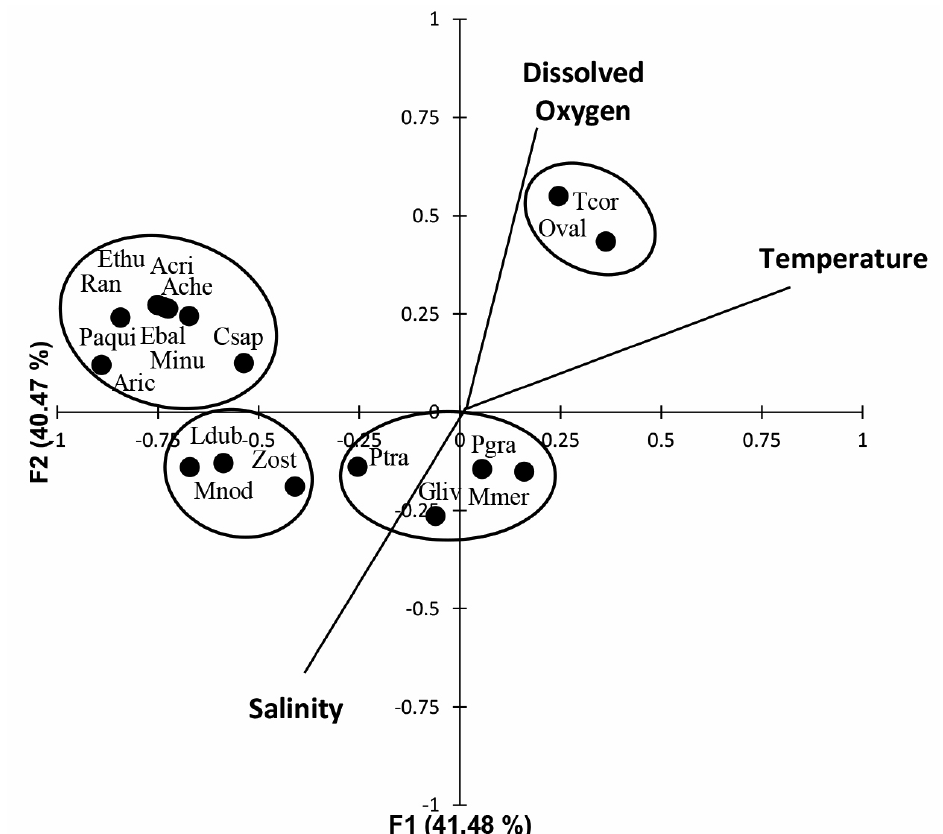
Figure 4. Canonical Correlation Analysis (CCA) between the density of brachyuran zoea I and temperature, salinity and dissolved oxygen ( F = 3.811, p < 0.001). Abbreviation of species names as per Table